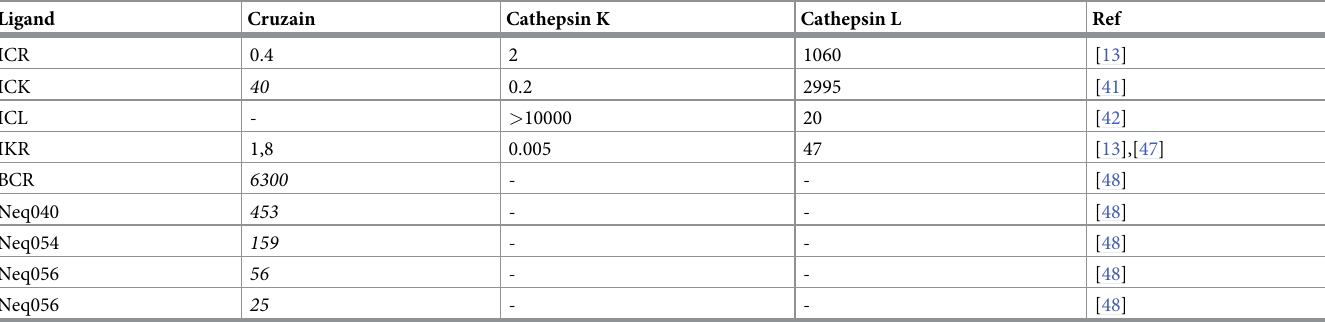
Table 1. IC50 values, in nM, of dipeptidyl nitriles against cruzain, cathepsin K and cathepsin L. Values in italics are Ki values rather than IC50s.